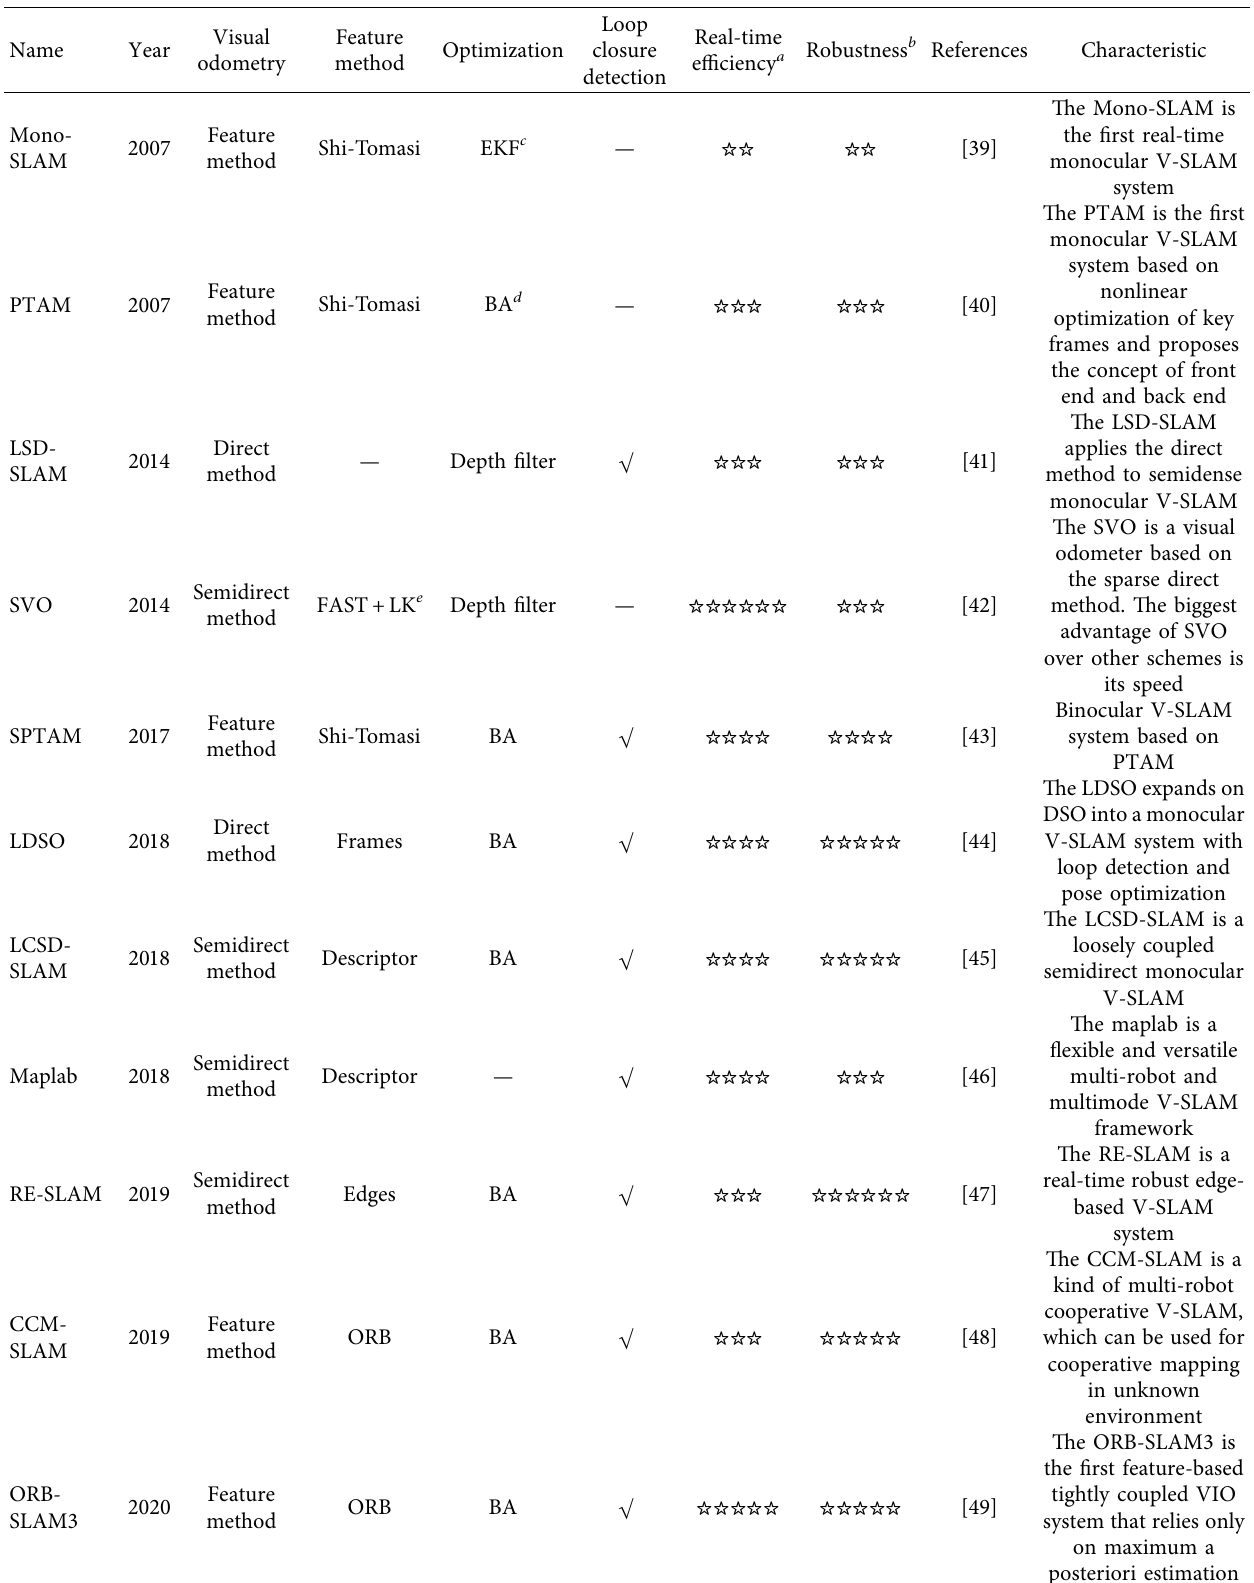
Table 2: Comprehensive evaluation of